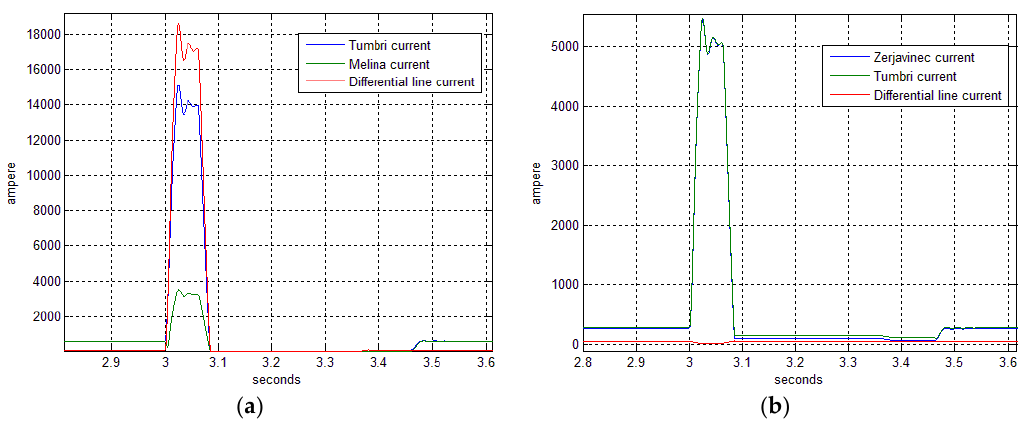
Figure 7. Values for line currents and line differential currents on two adjacent transmission lines: ( a ) Short circuit fault on Tumbri-Melina line with currents from both side of line with differential current Δ I ; ( b ) Tumbri-Zerjavinec line with fault current and differential current Δ I .